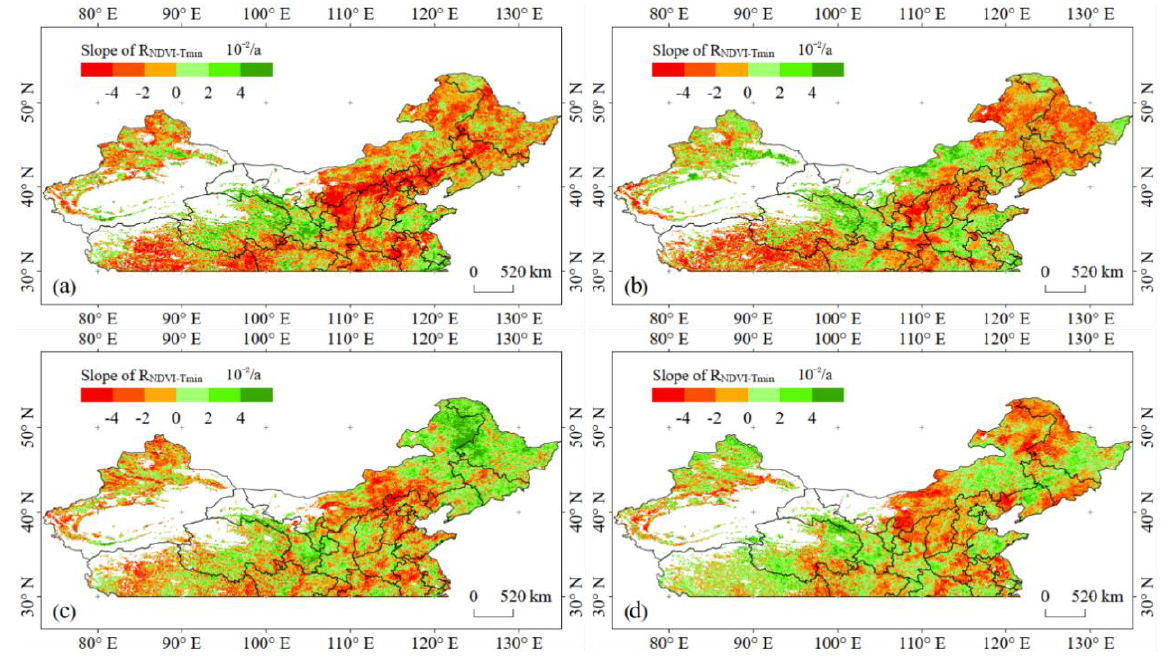
Figure 5. Spatial distribution of the trend of partial correlation coefficient between NDVI and nighttime temperature (R NDVI−Tmin ) during 1982–2015 for growing season ( a ), spring ( b ), summer ( c ) and autumn ( d ).